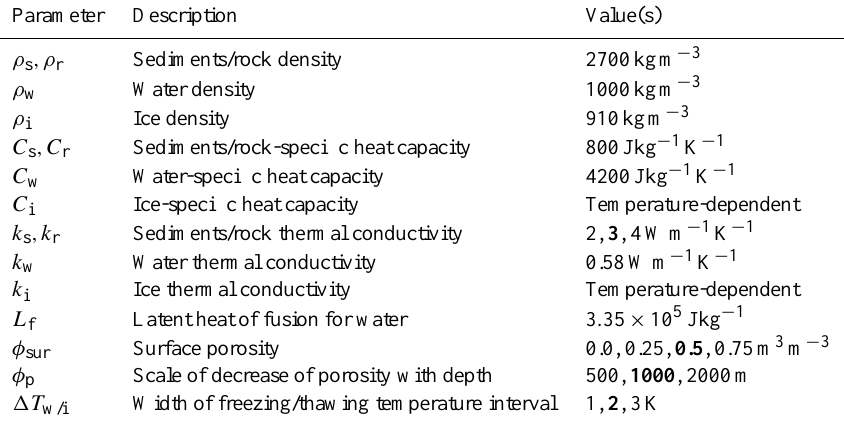
Table 1. Parameter description and values. Parameters where more than one value is listed are used in the sensitivity study. Bold values indicate the reference